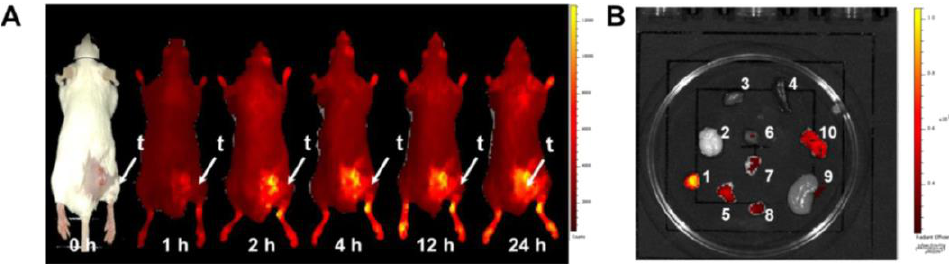
Figure 2. Fluorescence imaging showed accumulation of BPN in the tumor region. ( A ) Fluorescence images of 4T1 tumor-bearing mice 0, 1, 2, 4, 12, and 24 h post intravenous injection of 1 mg of BPN. ( B ) Fluorescence images of variant organs in 4T1 bearing mice 24 h post injection of BPN (TBPP = 1 mg): 1: tumor, 2: brain, 3: kidney, 4: spleen, 5: fat, 6: heart, 7: lung, 8: muscle, 9: liver, and 10: large intestine. Reproduced with permission from Shi et al. [109], 2018.